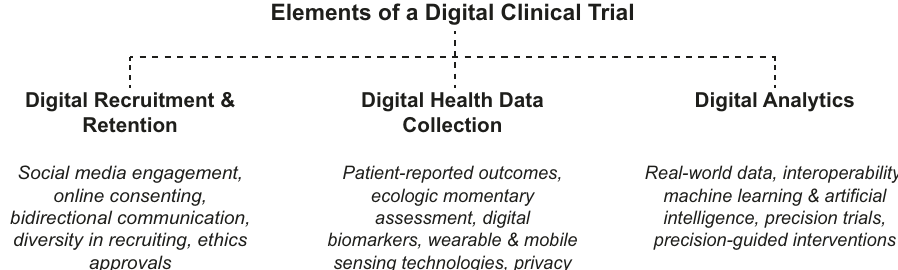
Fig. 1 Summary of the key elements of a digital clinical trial. Three elements discussed in this paper include digital recruitment and retention, digital health data collection, and digital